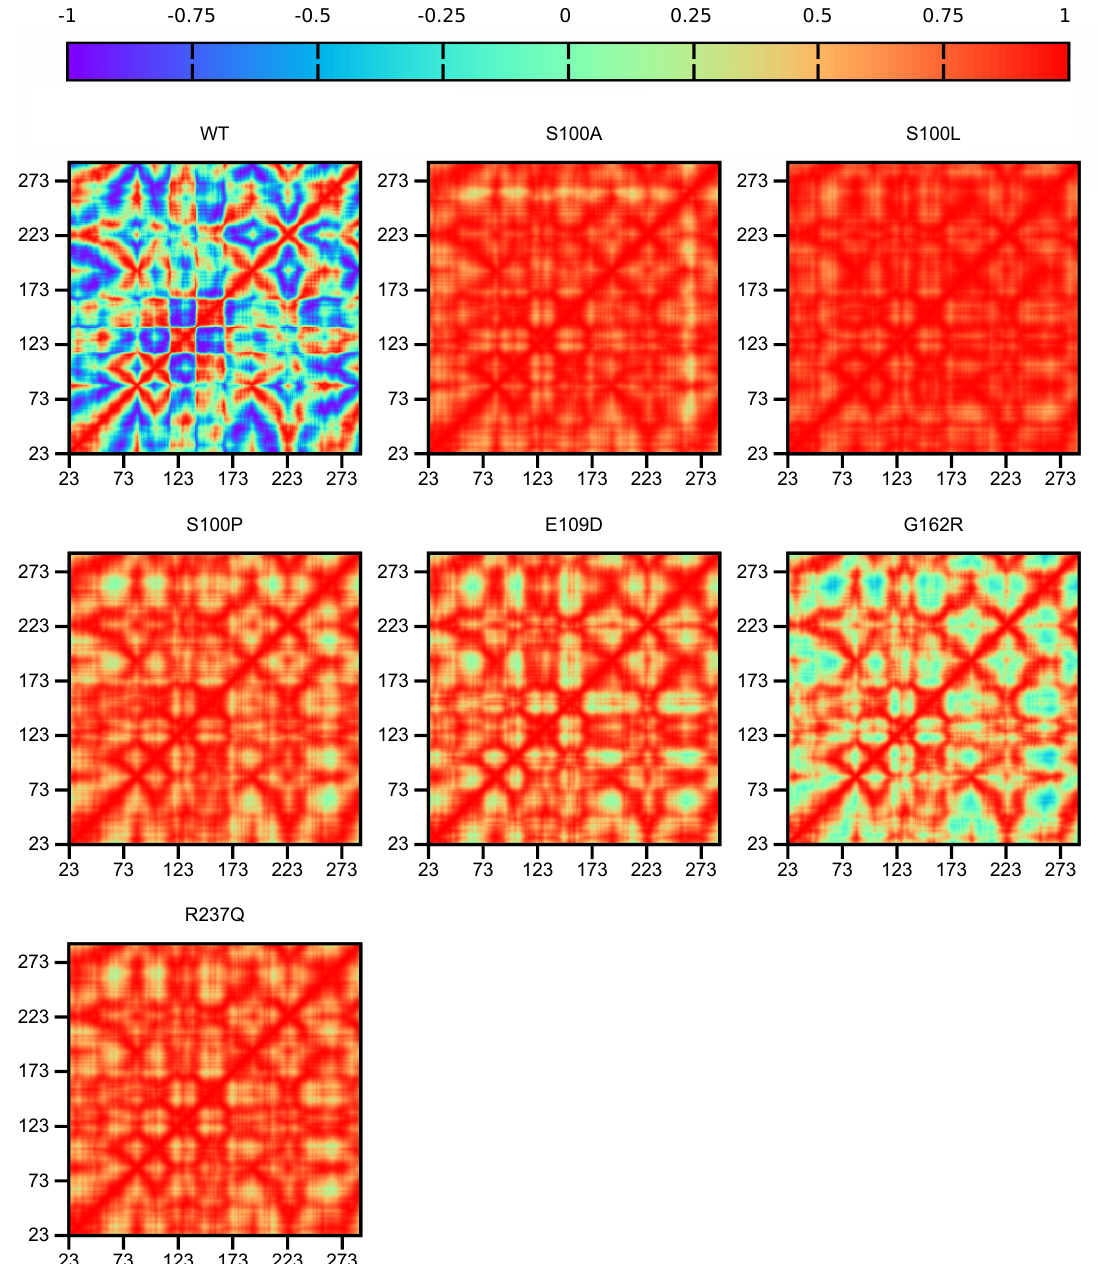
Figure 3. CA-VIII DCC analysis showing protein residue correlation comparison between the WT and proteins. The x -axis and y -axis represent protein residues. A value of − 1 indicates that residue movement is anti-correlated, 0 highlights no movement correlation and a value of 1 represents correlated residue